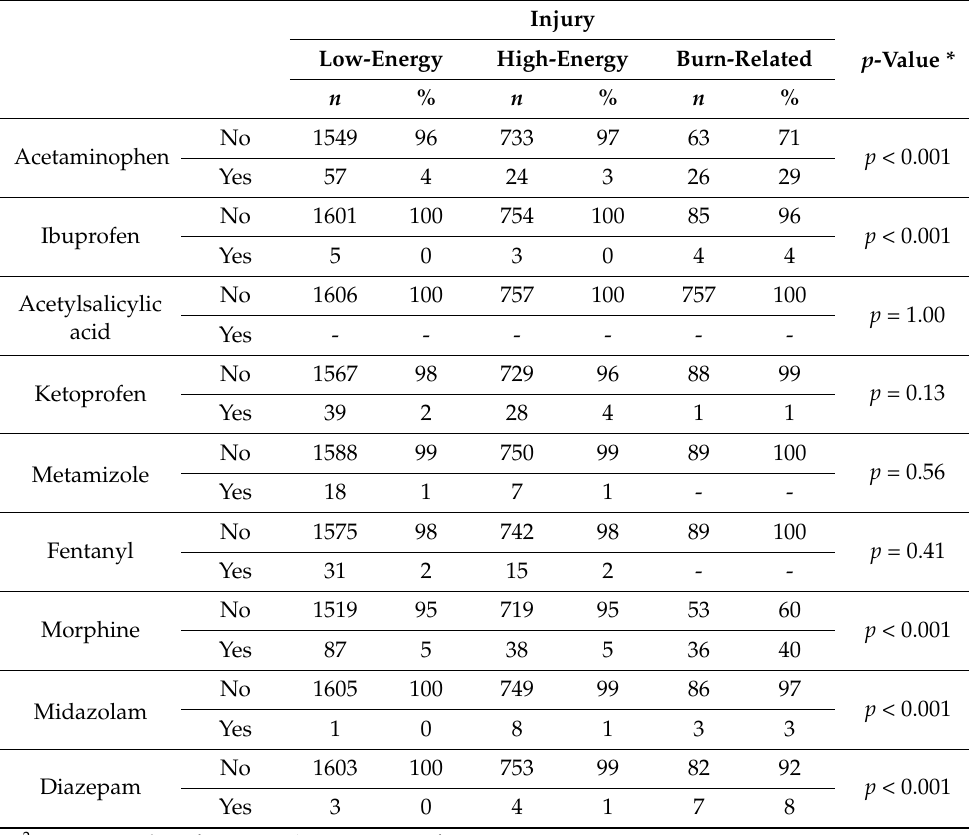
Table 3. The intake of individual analgesics and sedatives by mechanism of injury.